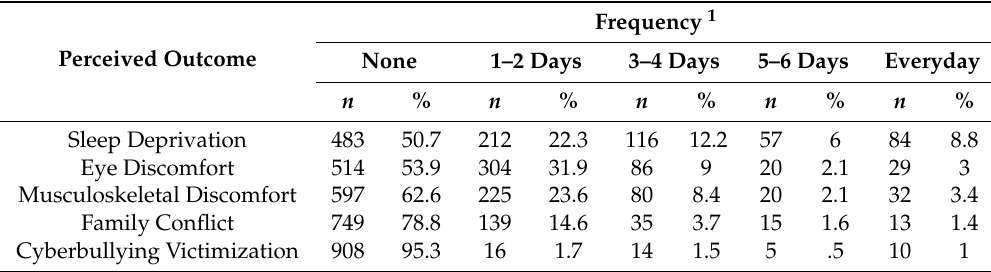
Table 5. Percentages of frequencies of physical and psychosocial outcomes related to smart device use in a week.